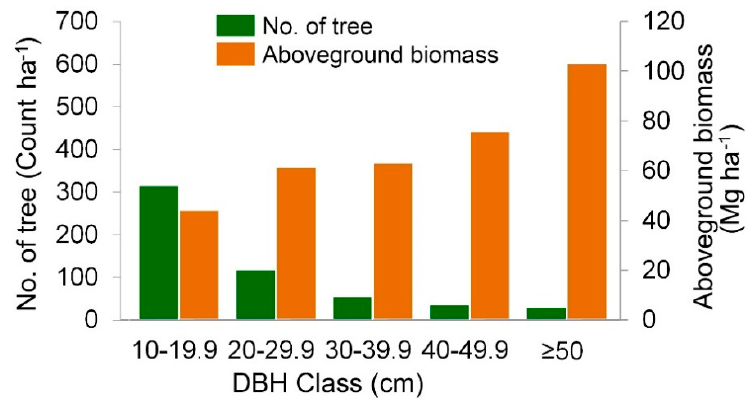
Figure 7. Relationship between tree size, number of trees, and AGB in a hectare of dipterocarp forest.